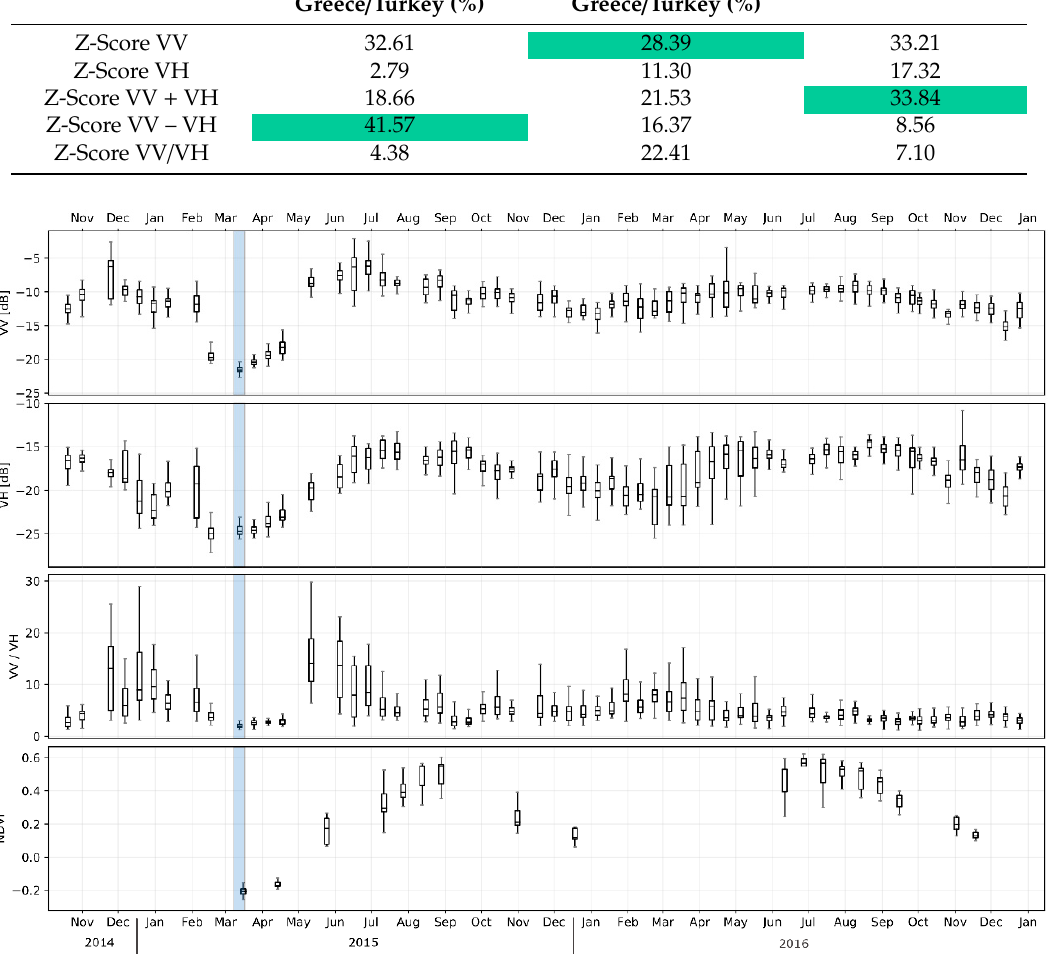
Table 5. Random forest importance analysis of the time series features for TFV and individual study areas. The rows highlighted in green represent the time series features with the highest contribution (importance).